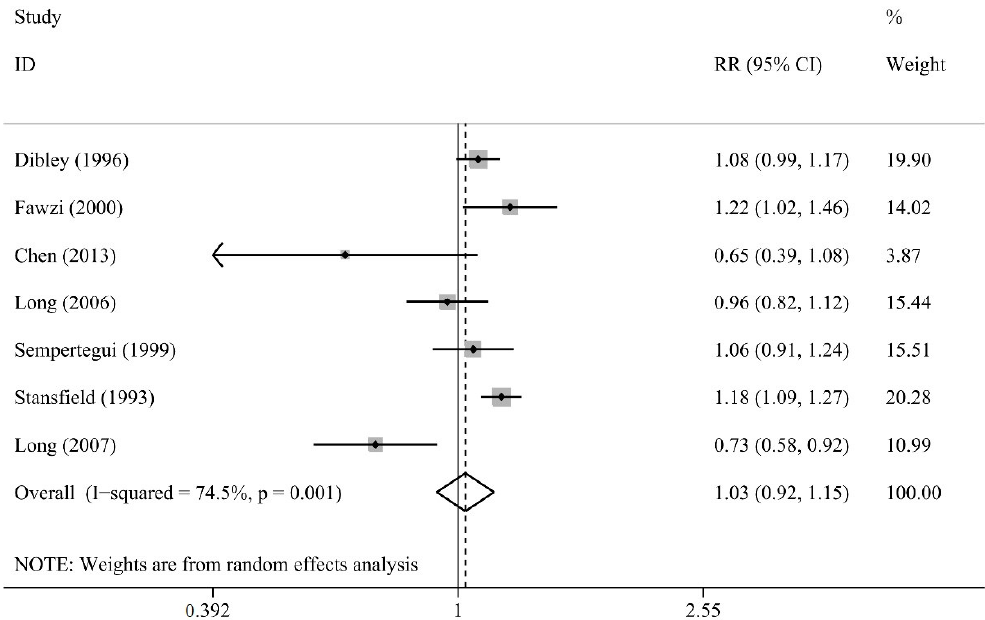
Figure 2. Comparison of Vitamin A versus Control, Outcome 1—incidence of acute respiratory tract infection (ARTI) at longest follow-up; RR: risk ratios or rate ratios.